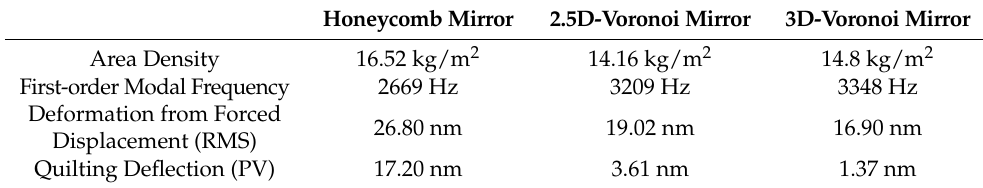
Table 3. Summary of the mirror